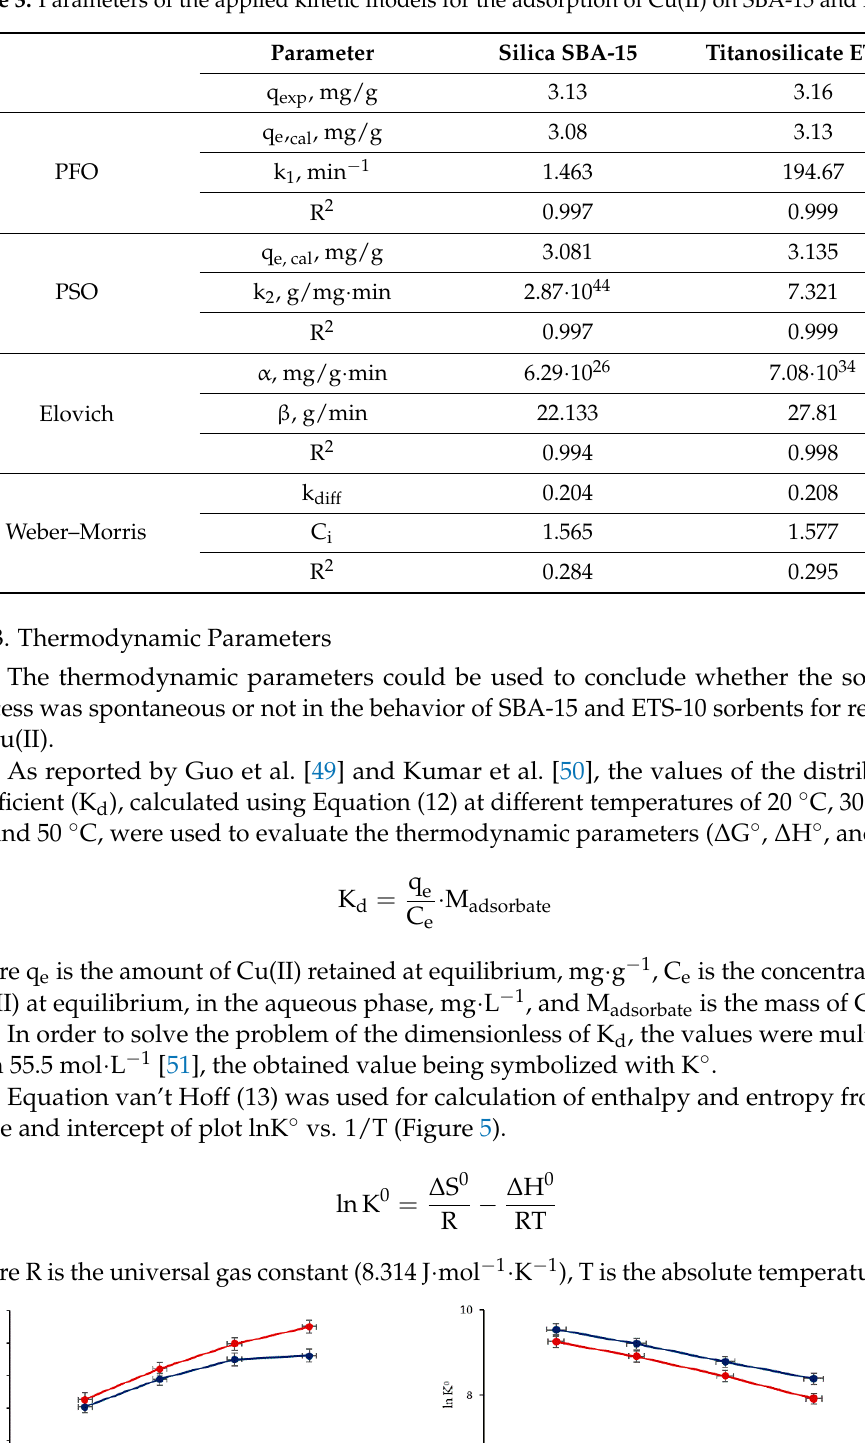
Table 3. Parameters of the applied kinetic models for the adsorption of Cu(II) on SBA-15 and ETS-10.